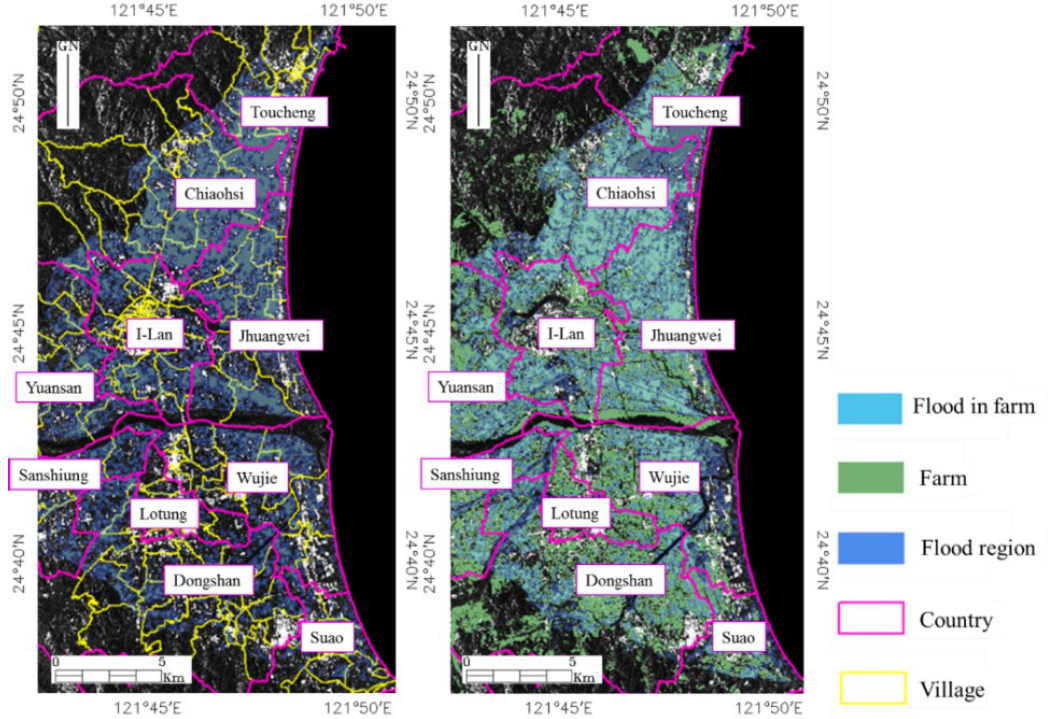
Figure 11. The flooded regions in I-Lan County, with a focus on farmland